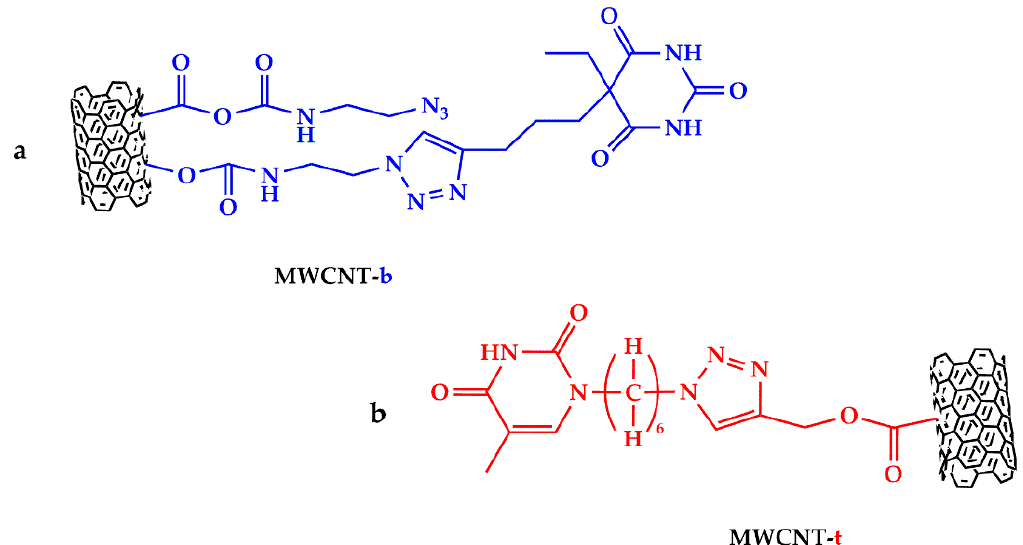
Figure 1. Carbon nanofillers functionalized with: ( a ) barbiturate-based ligand (MWCNT-b) and ( b ) thymine-based ligand (MWCNT-t).